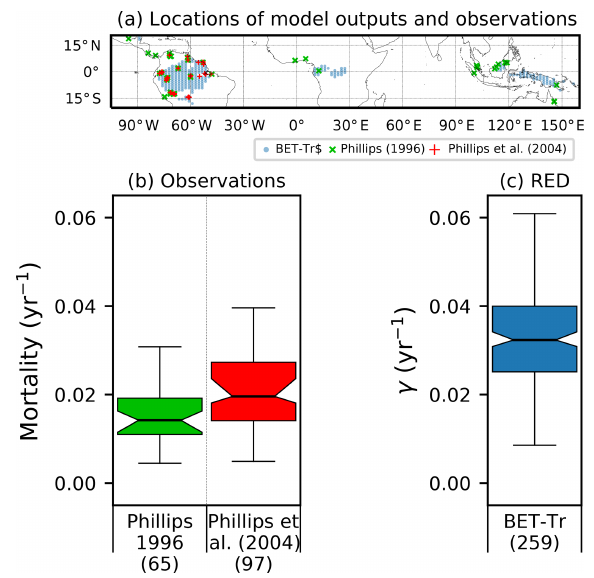
Figure 8. Comparison of observation-based estimates of tropical tree mortality (Phillips, 1996; Phillips et al., 2004) to γ values diag- nosed from RED for the BET-Tr PFT (for the top 25% of fractions for this PFT). (a) Location of observational sites (blue and green crosses) versus the chosen RED grid points (red circles); (b) dis- tribution of mortality across grid boxes; (c) mortality distribution across the BET-Tr grid points. Bracketed numbers in panel (b) rep- resent the number of measurements and in panel (c) the number of grid